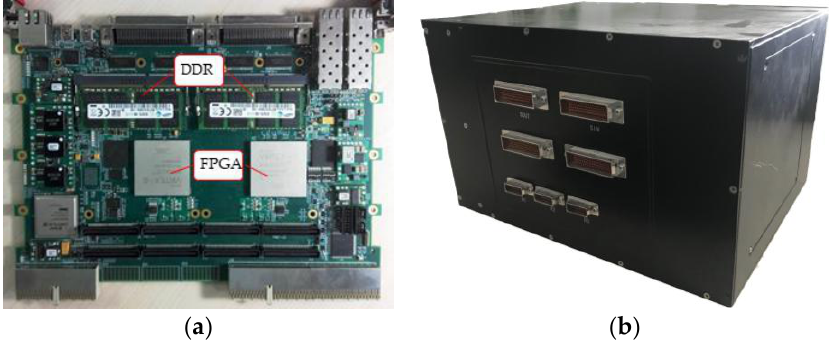
Figure 12. ( a ) Photographs of the board and ( b ) the prototype single machine. Table 9. The structuring indicators of the prototype single machine system.